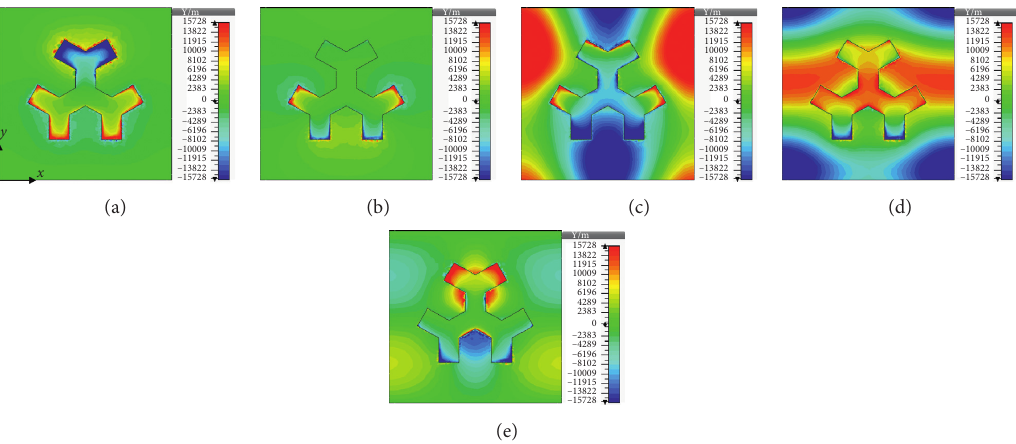
Figure 5: Electric field [real ( E z )] distribution corresponding to different peaks: (a) 5.984GHz, (b) 12.232GHz, (c) 18.128GHz, (d) 18.414 GHz, and (e)